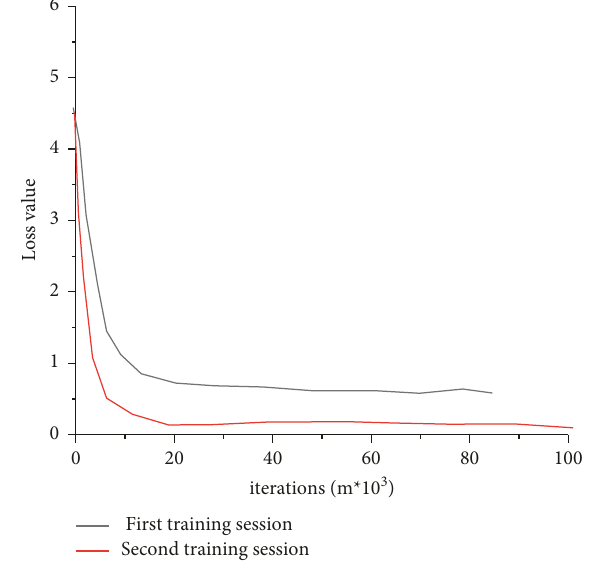
Figure 3: Loss function comparison Table 2: Performance of semantic segmentation model.